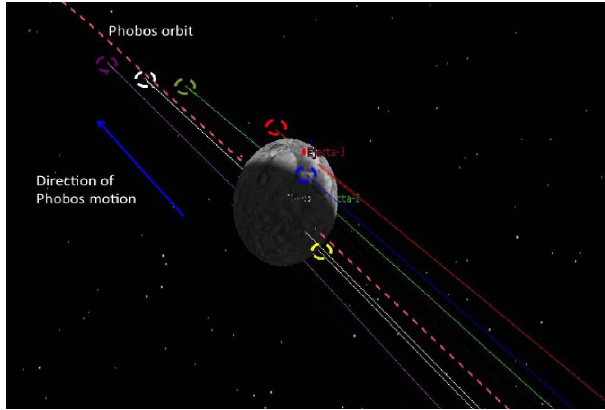
Figure 4 | Visualization of the orbital history of randomly selected particles. Shown are the trajectories of randomly selected projectiles ejected at 11–30ms (cid:3) 1 , which impact over a relatively short time in a grouped fashion. As Phobos moves along its orbit (towards the top of the figure, dashed pink line), ejected particles in the vicinity of Phobos’ orbit (purple, white, green, red and yellow lines) are reaccreted to the satellite. Dashed circles represent planetocentric impact points, illustrating how hemispherical catena (Fig. 5) may be